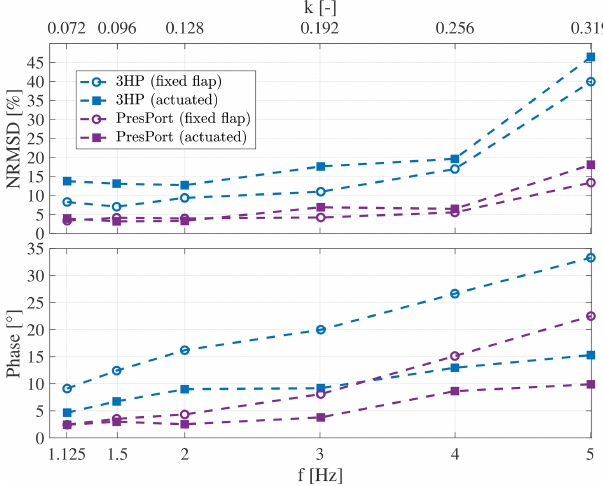
Figure 18. Normalized mean root square deviation and phase dif- ference between lift estimation methods and full pressure distribu- tion